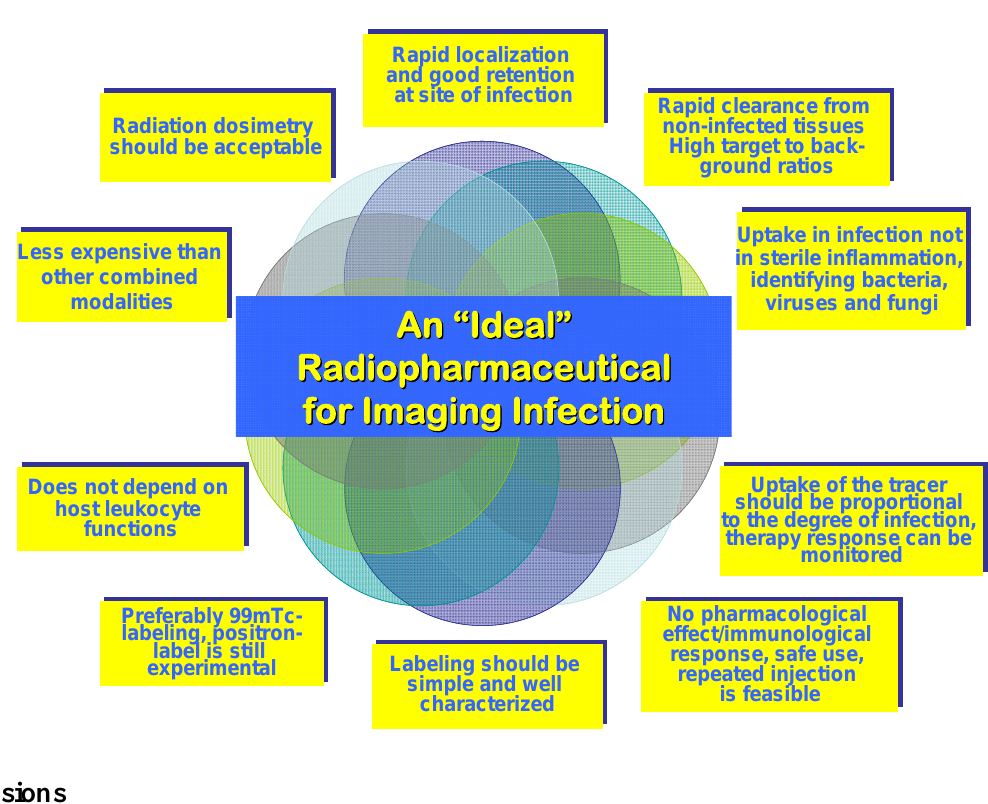
Figure 3. Criteria of an ideal